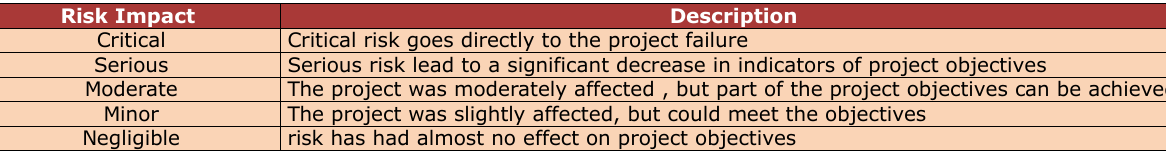
Table 2. Impact of risk (I)